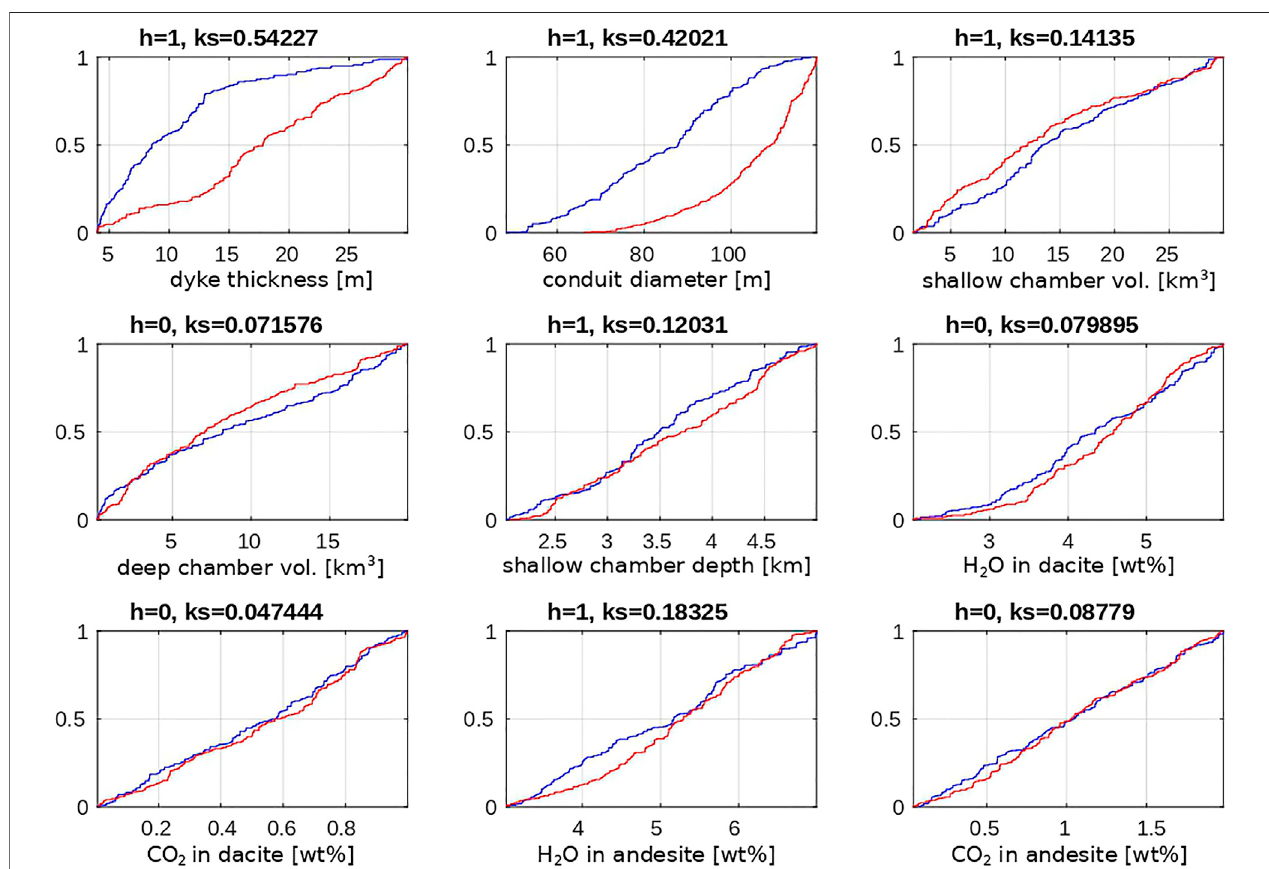
FIGURE 5 | Regional analysis results for eruption intensity less than (blue lines) or larger than (red lines) the value of 11.5. See Figure 3 for the interpretation.